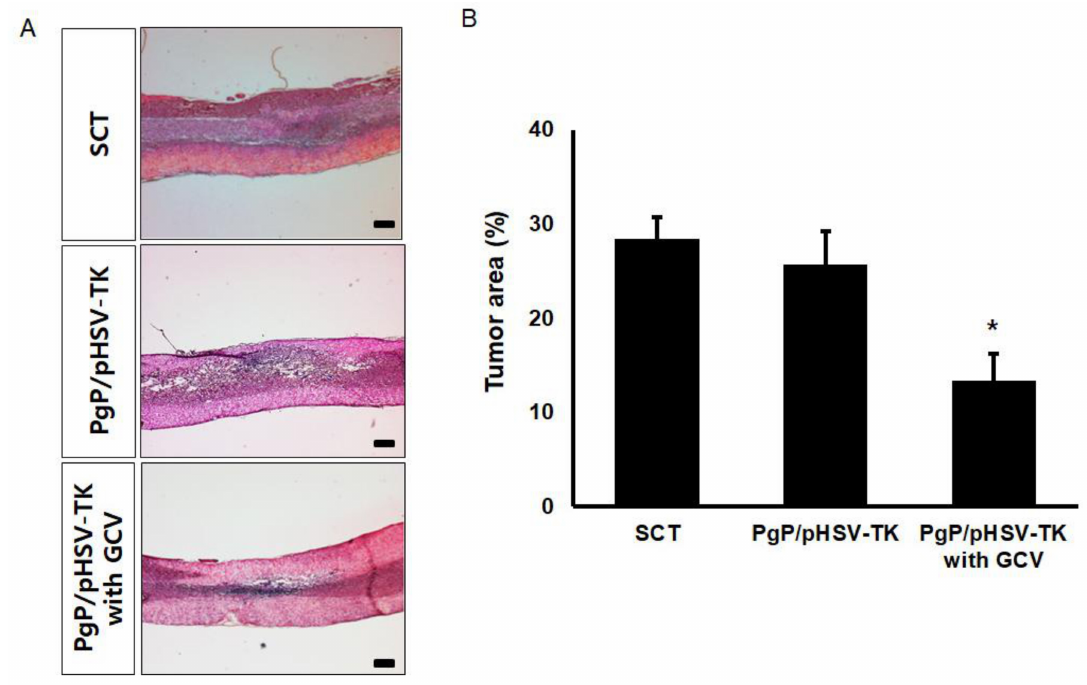
Figure 7. Histological analysis of the suicide e ff ect on tumor size at 10 days post-intratumoral injection of PgP / pHSV-TK (10 µ g pHSV-TK, N / P ratio of 60 / 1) polyplexes with GCV (40 mg / kg, intraperitoneal injection). ( A ) Representative images of H&E stained longitudinal spinal cord sections. Scale bars indicate 500 µ m. ( B ) The percent tumor area of spinal cord tumors. The % tumor area was measured and averaged from 16 di ff erent sections of spinal cords from each group (4 sections / rat, 4 rats / group). * p < 0.05 compared with untreated SCT